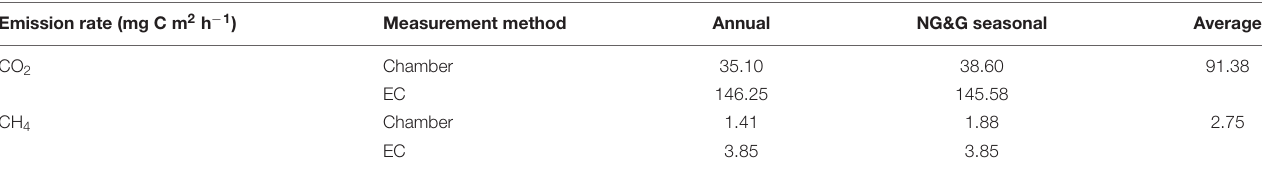
TABLE 1 | Extrapolated mean emission rate of CO 2 and CH 4 of study site for the period 1960–2017, based on models derived from data obtained using the chamber or EC method at different